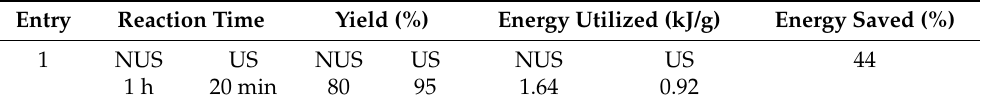
Table 2. Synthesis of 1%Pd-HPW/SiO 2 with the non-ultrasonic (non-US) and ultrasonic (US) methods. Entry Yield (%)